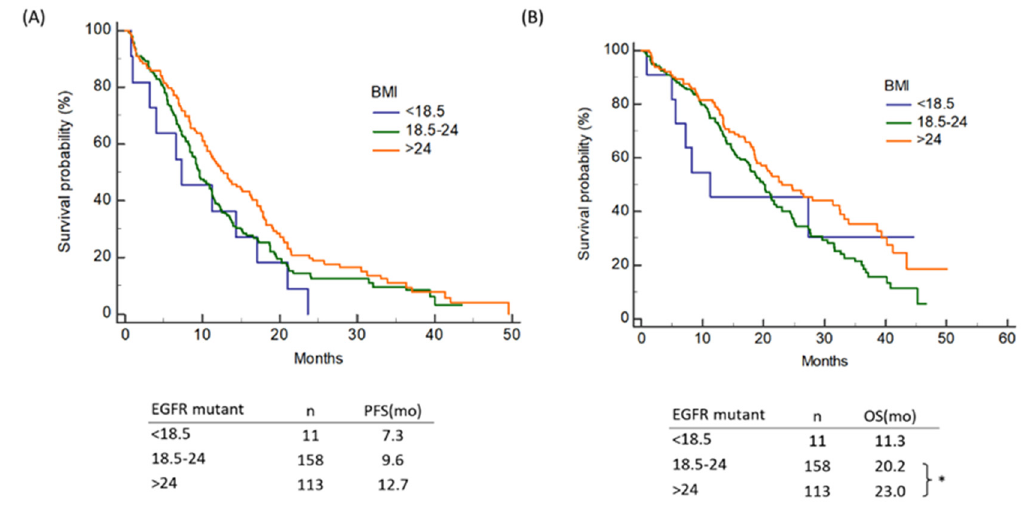
Figure 4. Influence of the baseline BMI on ( A ) PFS and ( B ) OS of NSCLC patients with EGFR mutation. BMI—body mass index; PFS—progression-free survival; OS—overall survival; NSCLC—non-small cell lung cancer; EGFR—epidermal growth factor receptor; Note: * p < 0.05.